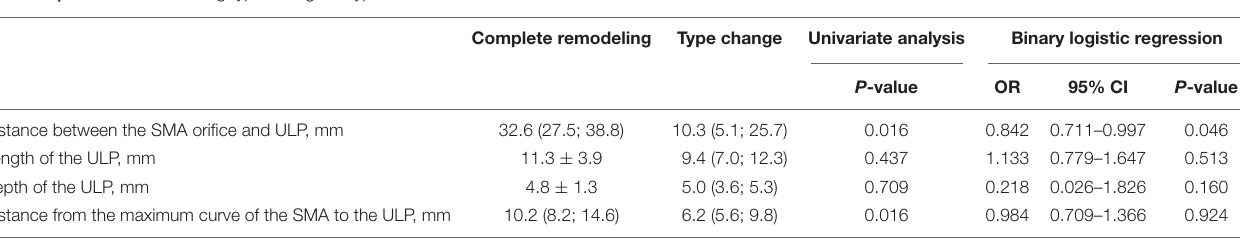
TABLE 4 | Determinant inducing type change in Type III SISMAD with thrombosed FL with ULP.